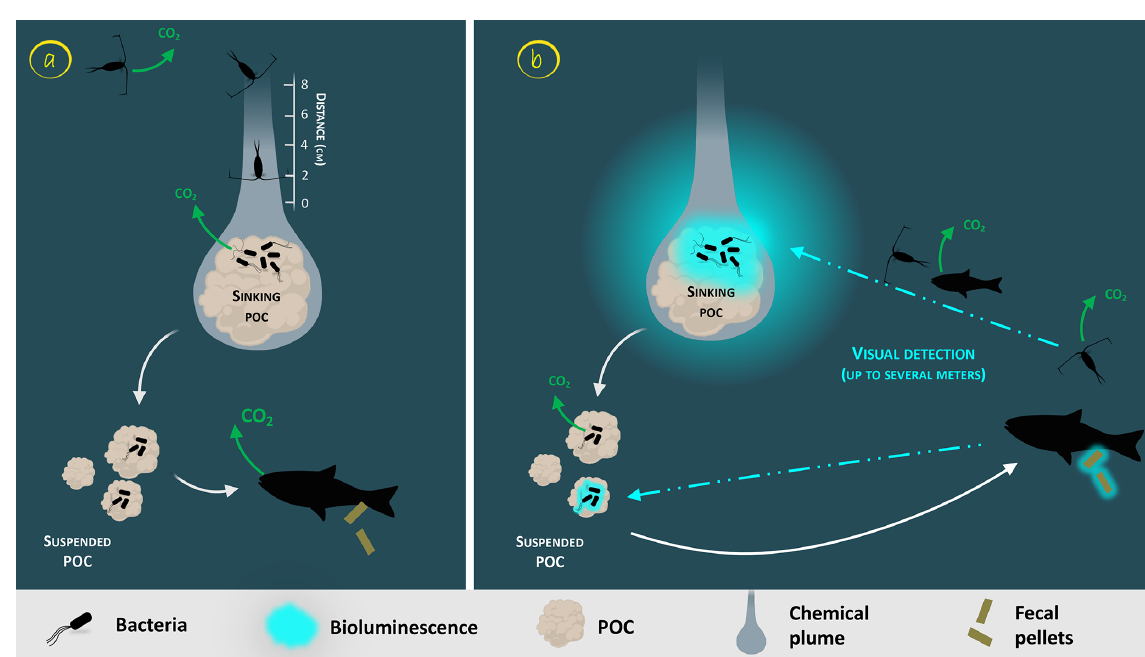
Figure 2. Zoom on the carbon fluxes at the level of a gravitational sinking particle (inspired by Azam and Long, 2001). The sinking POC is moving downward followed by the chemical plume (Kiørboe, 2011). The plain white arrows represent the carbon flow. Panel (a) represents the classical view of a non-bioluminescent particle. The length of the plume is identified by the scale on the side (Kiørboe and Jackson, 2001). Panel (b) represents the case of a glowing particle in the bioluminescence shunt hypothesis. Bioluminescent bacteria are represented aggregated onto the particle. Their light emission is shown as a bluish cloud around it. Blue dotted arrows represent the visual detection and the movement toward the particle of the consumer organisms. Increasing the visual detection allows a better detection by upper trophic levels, potentially leading to the fragmentation of sinking POC into suspended POC due to sloppy feeding. The consumption of the bioluminescent POC by fish can lead to the emission of bioluminescent fecal pellets (repackaging), which can also be produced with non-bioluminescent POC if the fish gut is already charged with bioluminescent